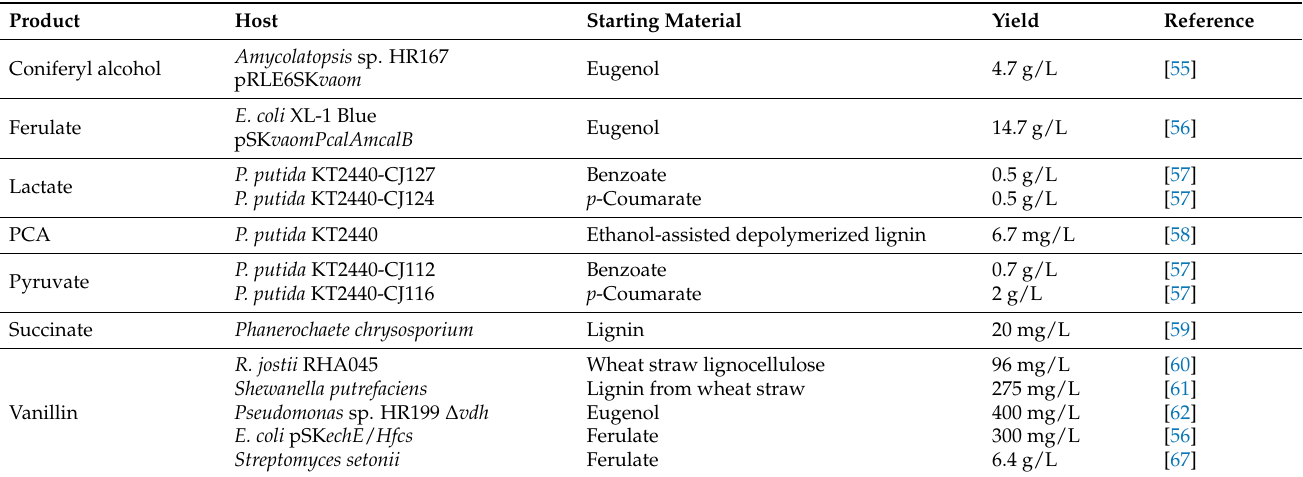
Table 2. Value-added compounds obtained from lignin or lignin-derived aromatics by microbial degradation